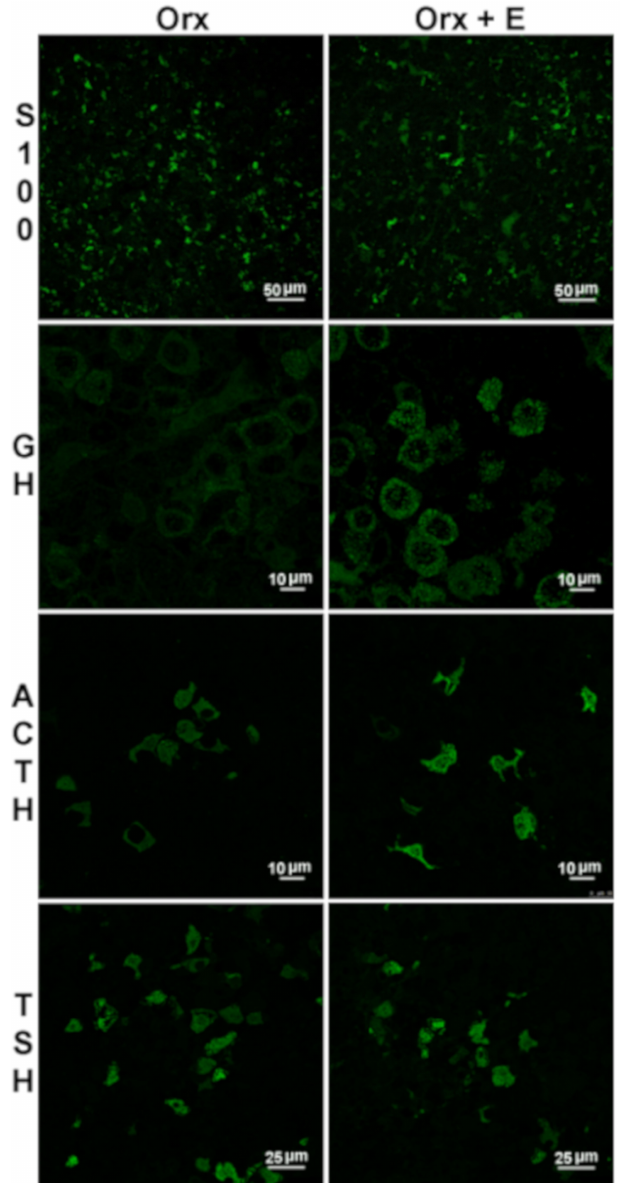
Figure 4. Representative micrographs of immunofluorescently (IFC) stained anterior pituitary sections of orchidectomized (Orx) and estradiol-treated orchidectomized (Orx + E) middle-aged rats. Weaker immunofluorescent signal of S100 β , stronger growth hormone (GH; adopted from our previous publication [99] and reprinted by permission of the Licensors - publishers Springer (Licence number 4774320912101)) and adrenocorticotropic hormone (ACTH) immunofluorescent signal, and unchanged immunofluorescent signal of subunit β of thyroid-stimulating hormone (TSH β ; adopted from our previous publication [55] and reprinted by permission of the Licensors - publishers Elsevier (Licence number 4774000297301)), respectively, are observable after estradiol treatment. All figures were obtained according to the same procedure described in our earlier papers [55,99]. Briefly, for IFC staining, the following primary antibodies were applied overnight at 4 ◦ C: mouse monoclonal anti-S100 β antibody (Abcam, Cambridge, UK; 1:100), polyclonal rabbit anti–rat TSH β , GH and ACTH (donation from Dr. A. F. Parlow, National Institute of Health, Bethesda, MD, USA; dilutions 1:500, 1:200, 1:200, respectively). Alexa Fluor 488 donkey anti-rabbit IgG (Invitrogen Life technologies, CA, USA; 1:300) was applied as secondary antiserum for 1 h. The sections were mounted with Mowiol 4–88 (Sigma-Aldrich, St. Louis, MO, USA). Scale bar is shown in the right